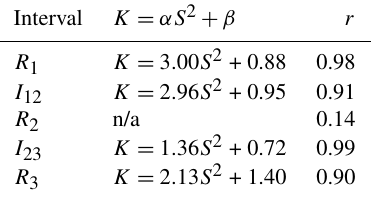
Figure 7. Kurtosis K as a function of skewness S computed from the time series of δ | B | (τ) , where τ = 100s. (a) The interior region of IMFR-1, (b) the interface of IMFR-1 and IMFR-2, (c) the in- terior of IMFR-2, (d) the interface of IMFR-2 and IMFR-3, and (e) the interior of IMFR-3. In each panel, the least-square fit with the parabolic function K = αS 2 + β is displayed as a dashed line (see Table